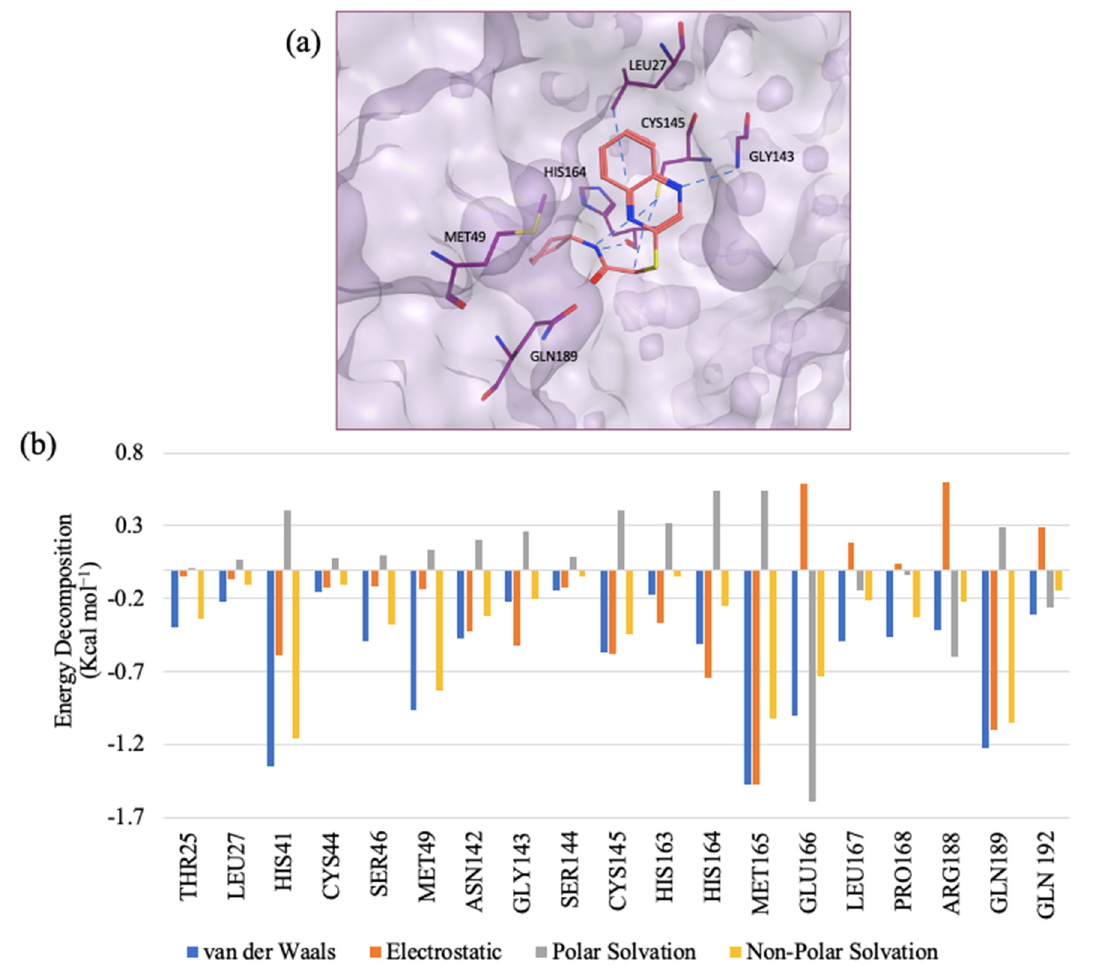
Figure 3. ( a ) The predicted binding mode of CB03 in the target catalytic site. ( b ) Pairwise energy decomposition graph illustrating residue contribution in protein–ligand (CB03) complex.